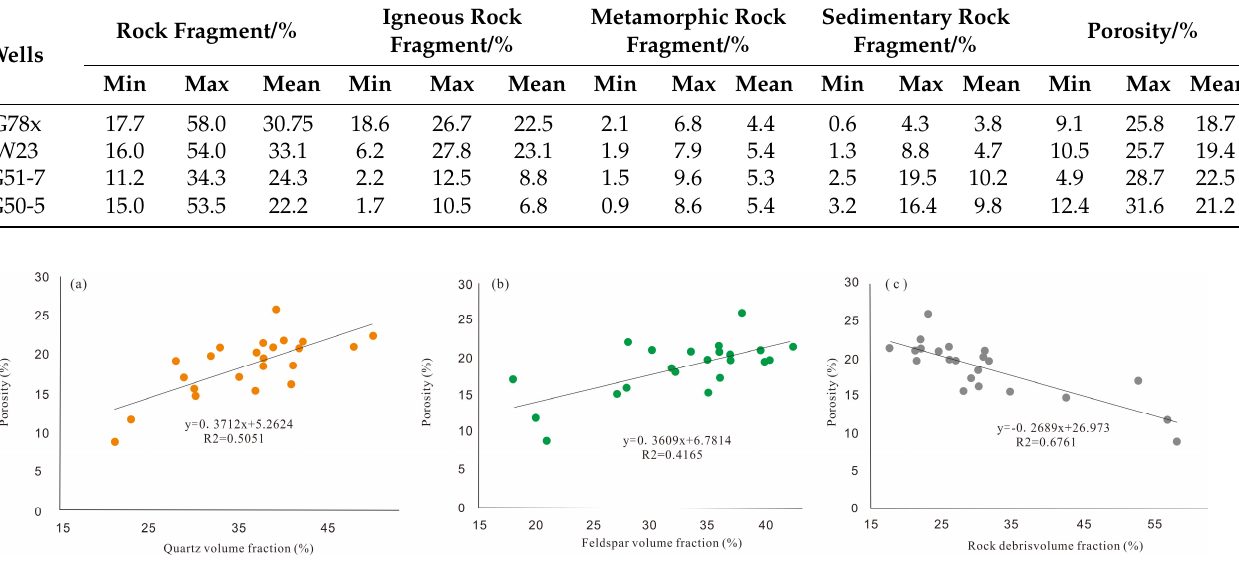
Figure 9. Correlation between clastic composition and porosity of Ek1 Formation in the Wang Guantun area. ( a ) porosity and quartz volume fraction; ( b ) porosity and feldspar volume fraction; ( c ) porosity and rock debris volume fraction.